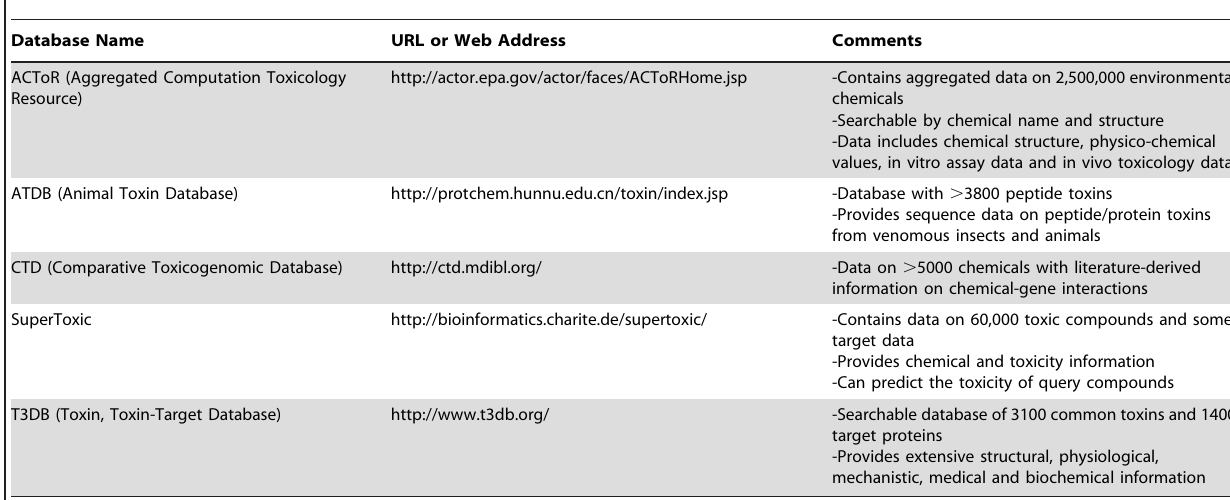
Table 4. Alphabetical Listing of Toxic Compound